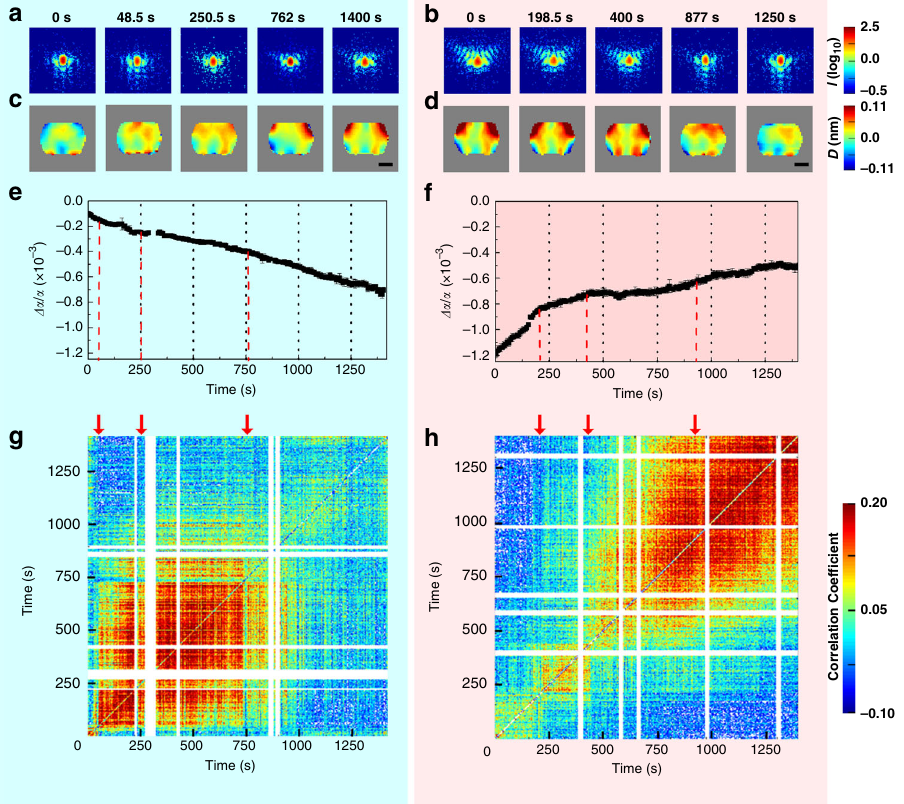
Fig. 2 Lattice constant and deformation during propene adsorption and NO x deoxygenation. The CXD patterns ( a , b ), the projected displacement fi eld maps ( c , d ), the strain-rate coef fi cients ( e , f ), and the cross-correlation coef fi cient plot of displacement fi eld results ( g , h ) during propene adsorption (in the light blue panel) and NO x deoxygenation process (in the light magenta panel), respectively. During the propene adsorption, the CXD patterns in a . Show that the fringes beside the central peak start rising to a higher wave vector at 250.5 s and continue until 1400 s. Once the NO x deoxygenation starts, the patterns in b . Change signi fi cantly but abruptly return to the initial state at 877 s. The projected displacement fi eld during propene adsorption in c . Shows an arched shape at 48.5 and 250.5 s, which spreads to the upper side and becomes enhanced at 1400 s. In the NO x deoxygenation, the displacement in d . Shows maximum displacement at the beginning, and then returns to its original state at 877 s. The scale bar corresponds to 1.0 μ m. The strain-rate coef fi cients in e , f are provided in Supplementary Table 2. The cross-correlation of displacements in g , h shows coef fi cients from − 0.1 to 0.2, where 1 indicates identical displacement, 0 no relation, and a negative sign the opposite direction. The white lines are due to missing data related to the instability of the XFEL